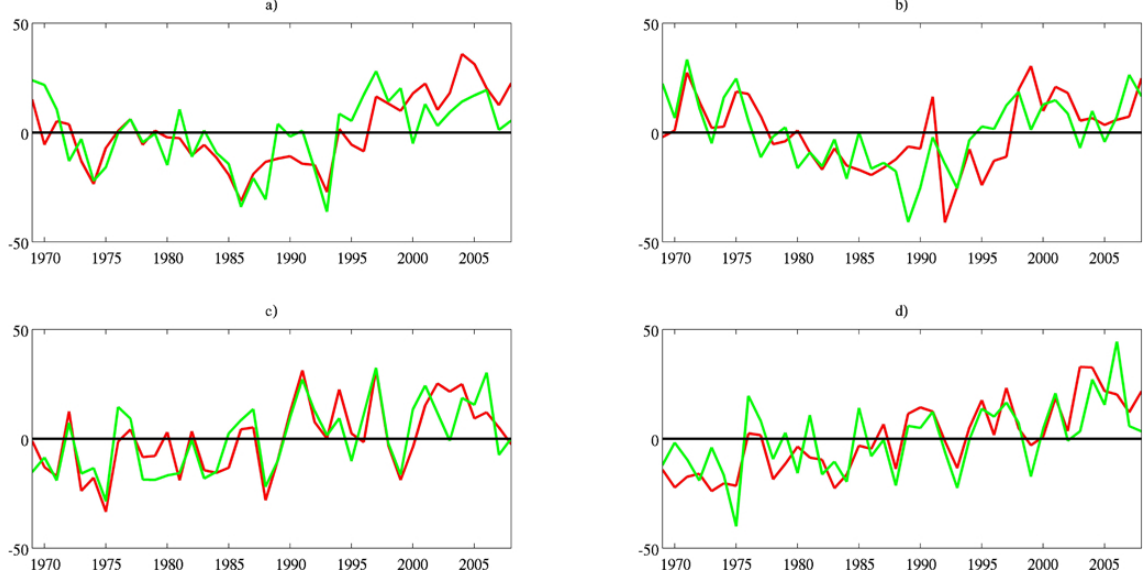
Fig. 7. Normalized time series for high order modes, from 1969 to 2008. (a) ACM mode 2, (b) FRD mode 3, (c) FRD mode 2 and (d) p10 mode 2. Red lines are for July SST modes and green lines are for ASO precipitation modes. Canonical correlation of these modes are 0.7, 0.6, 0.8 and 0.7, respectively, with statistical significance greater than 99% ( α < 1%) all of them, except for the latter that has 95% (1 <α < 5%), according to Davis (1976).